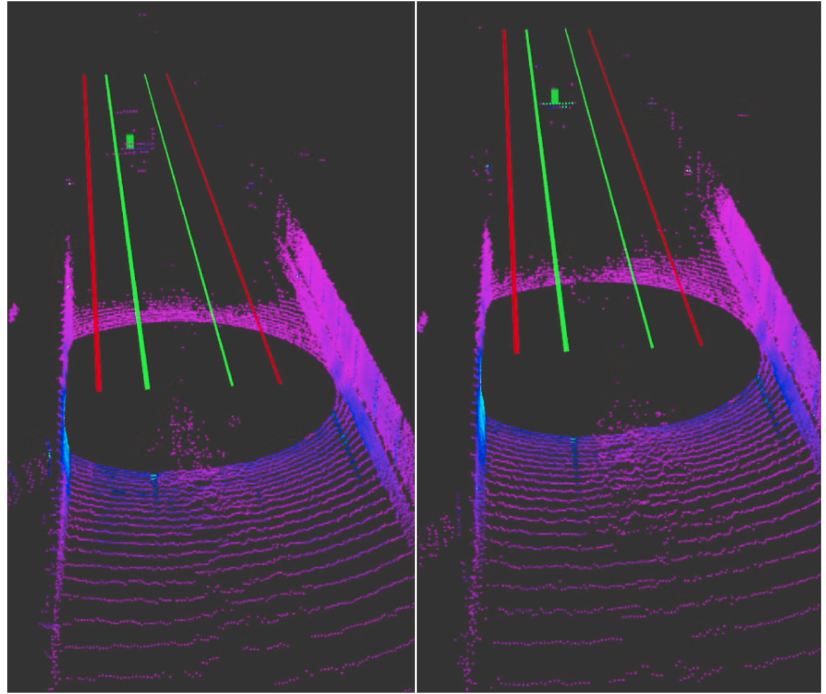
Figure 14. Demonstration of the sensor operations and sensor fusion [72] in heavy rain condition with rain from the environment plus the rain simulated from the ACM’s rain truck